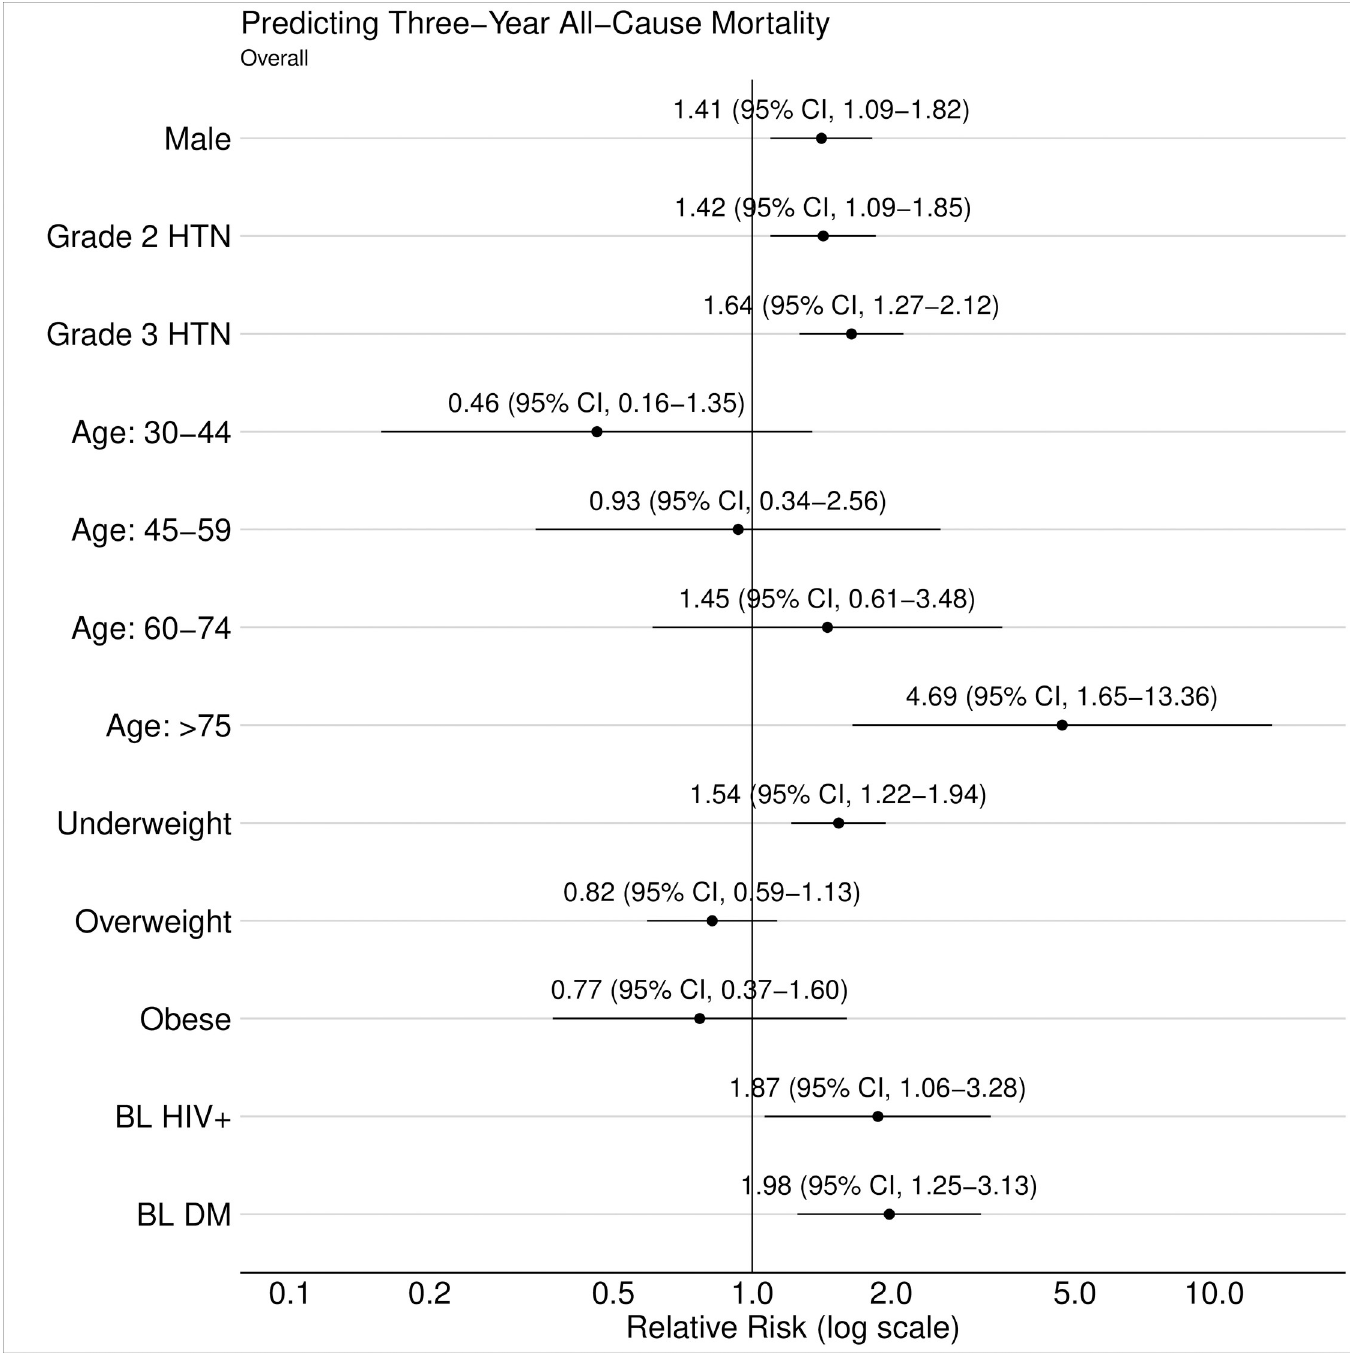
Fig 6. Predictors of 3-year mortality. Predictors of mortality by study year 3 using multivariable TMLE, with relative risks for each variable compared to reference value. Horizontal error bars depict predictor-specific 95% CIs. Reference values for relevant categorical variables include female, grade 1 hypertension, age 18–29 years, normal BMI, baseline HIV uninfected, and baseline absence of diabetes. Baseline hypertension severity defined by lowest of 3 BP measurements and classified as Grade 1 (BP 140– 159/90–99 mm Hg), Grade 2 (BP 160–179/100–109 mm Hg), Grade 3 (BP � 180/110 mm Hg). BMI categories include underweight (BMI < 18.5 kg/m 2 ), normal (BMI 18.5–24.9 kg/m 2 ), overweight (BMI 25–29.9 kg/m 2 ), or obese (BMI � 30 kg/m 2 ). BL, baseline; BMI, body mass index; BP, blood pressure; CI, confidence interval; DM, diabetes mellitus; HTN, hypertension; TMLE, targeted maximum likelihood estimation.